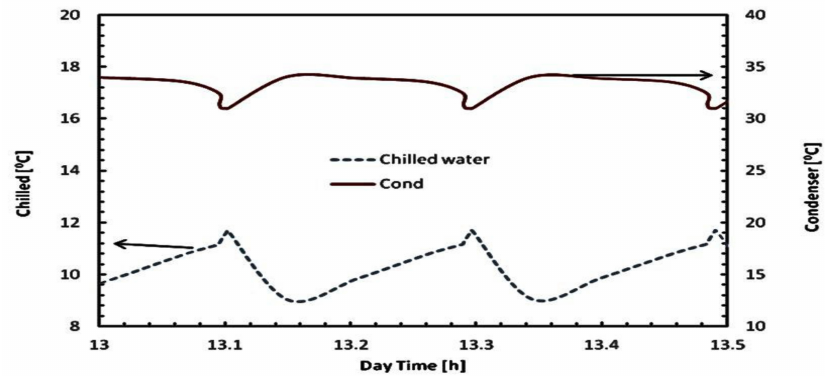
Figure 6. Water temperature at the outlets of both the condenser and evaporator.